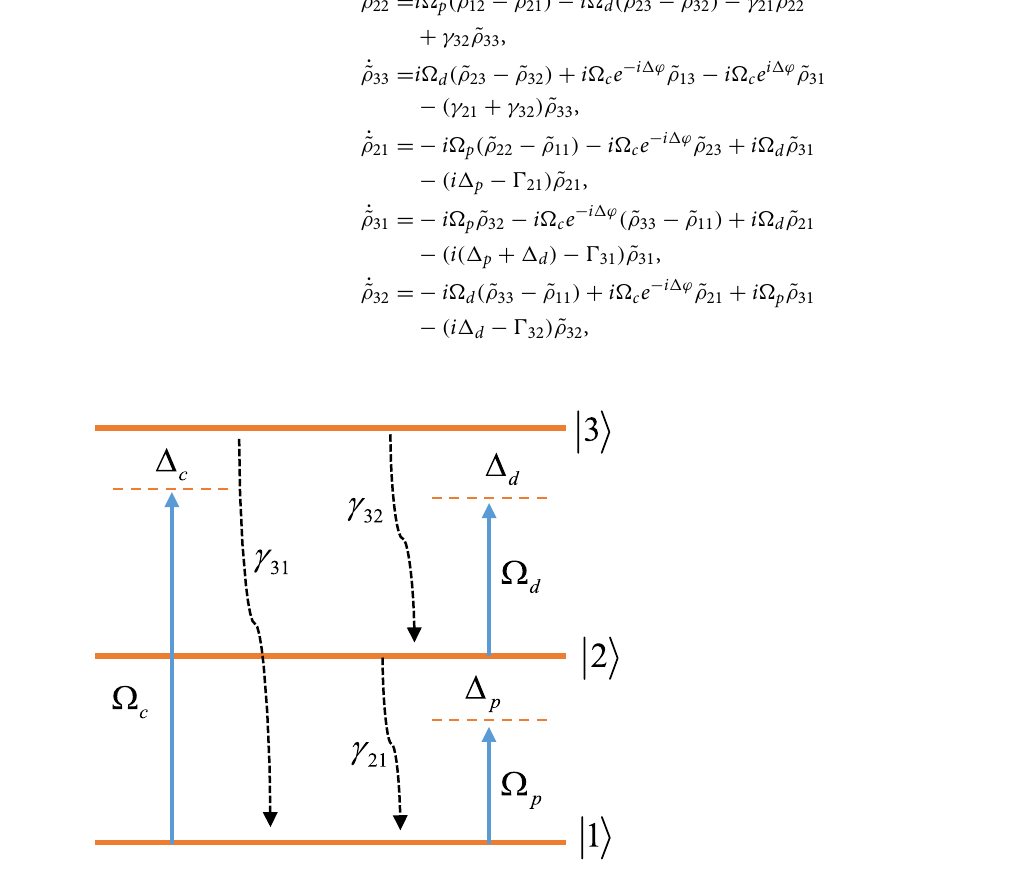
Figure 1. Diagram of a